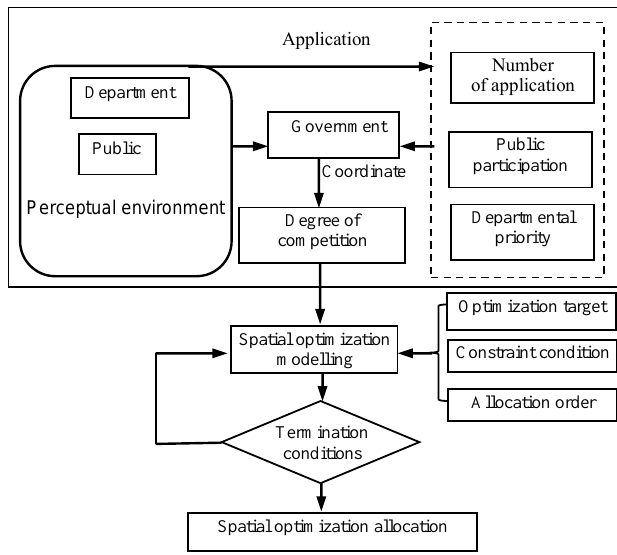
Figure 2. Model framework of multi-agent spatial optimization